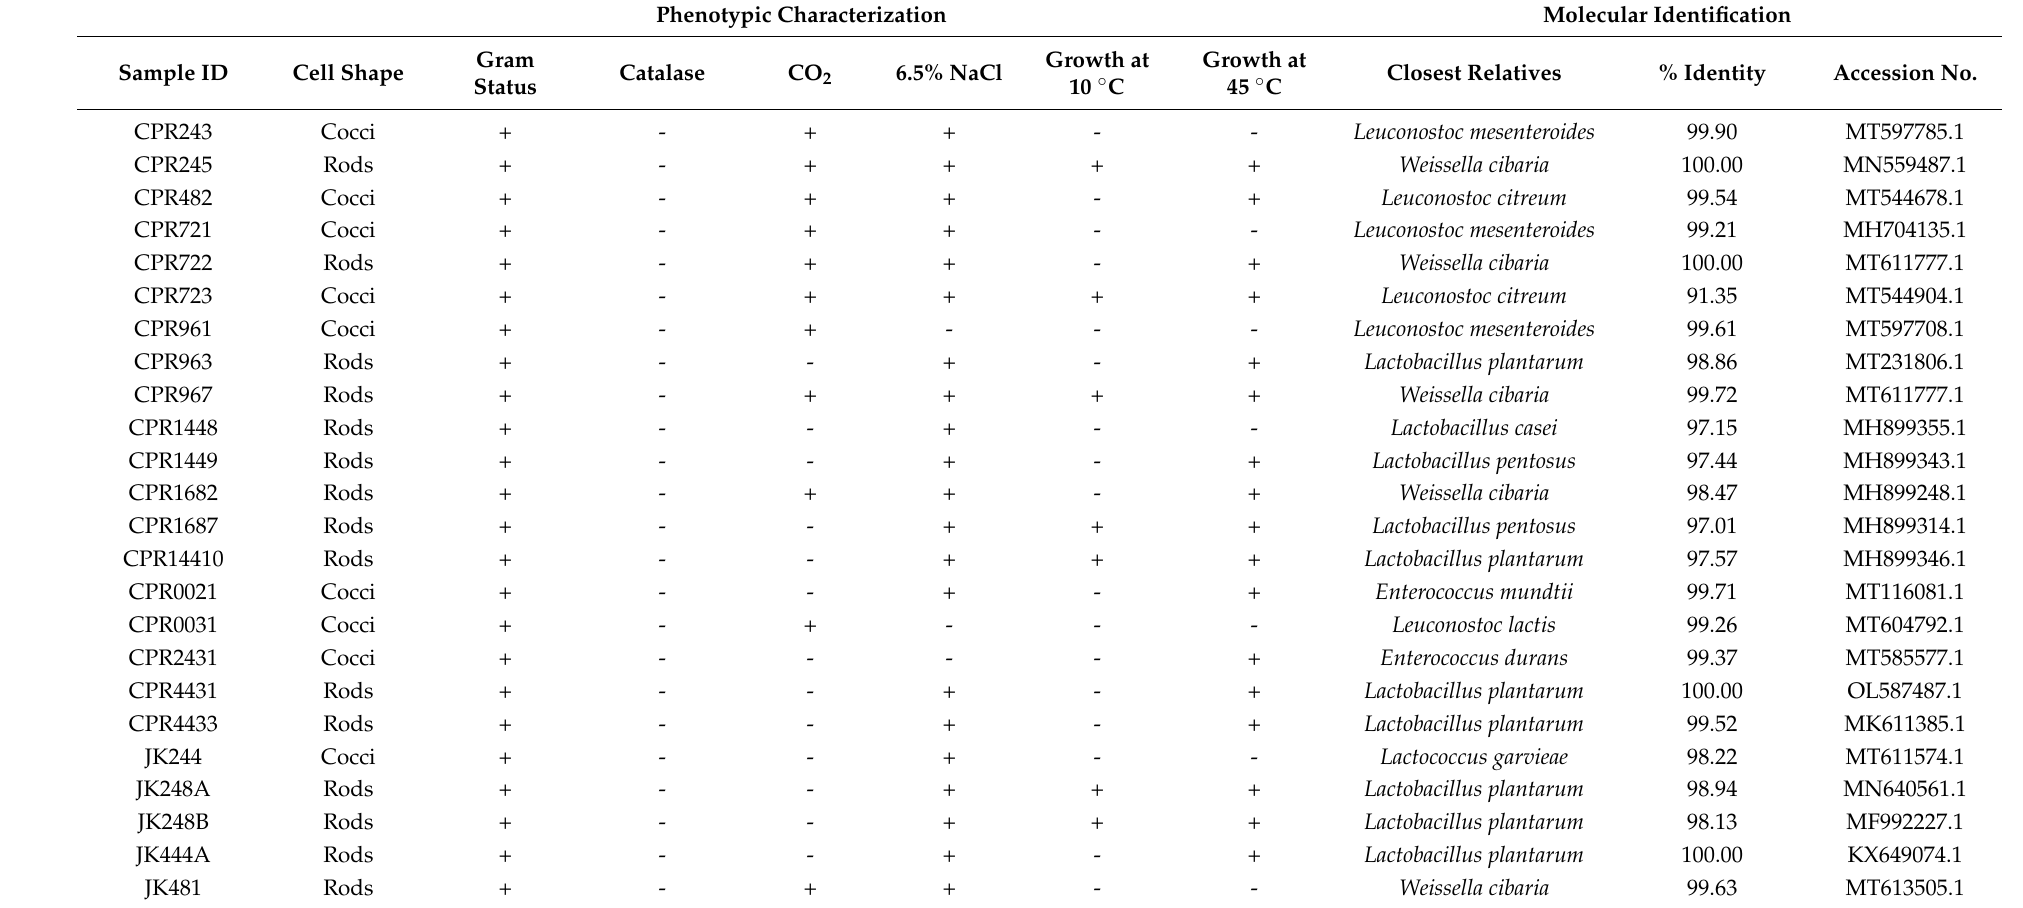
Table 1. Phenotypic and molecular identification of lactic acid bacteria from cowpea and amaranth